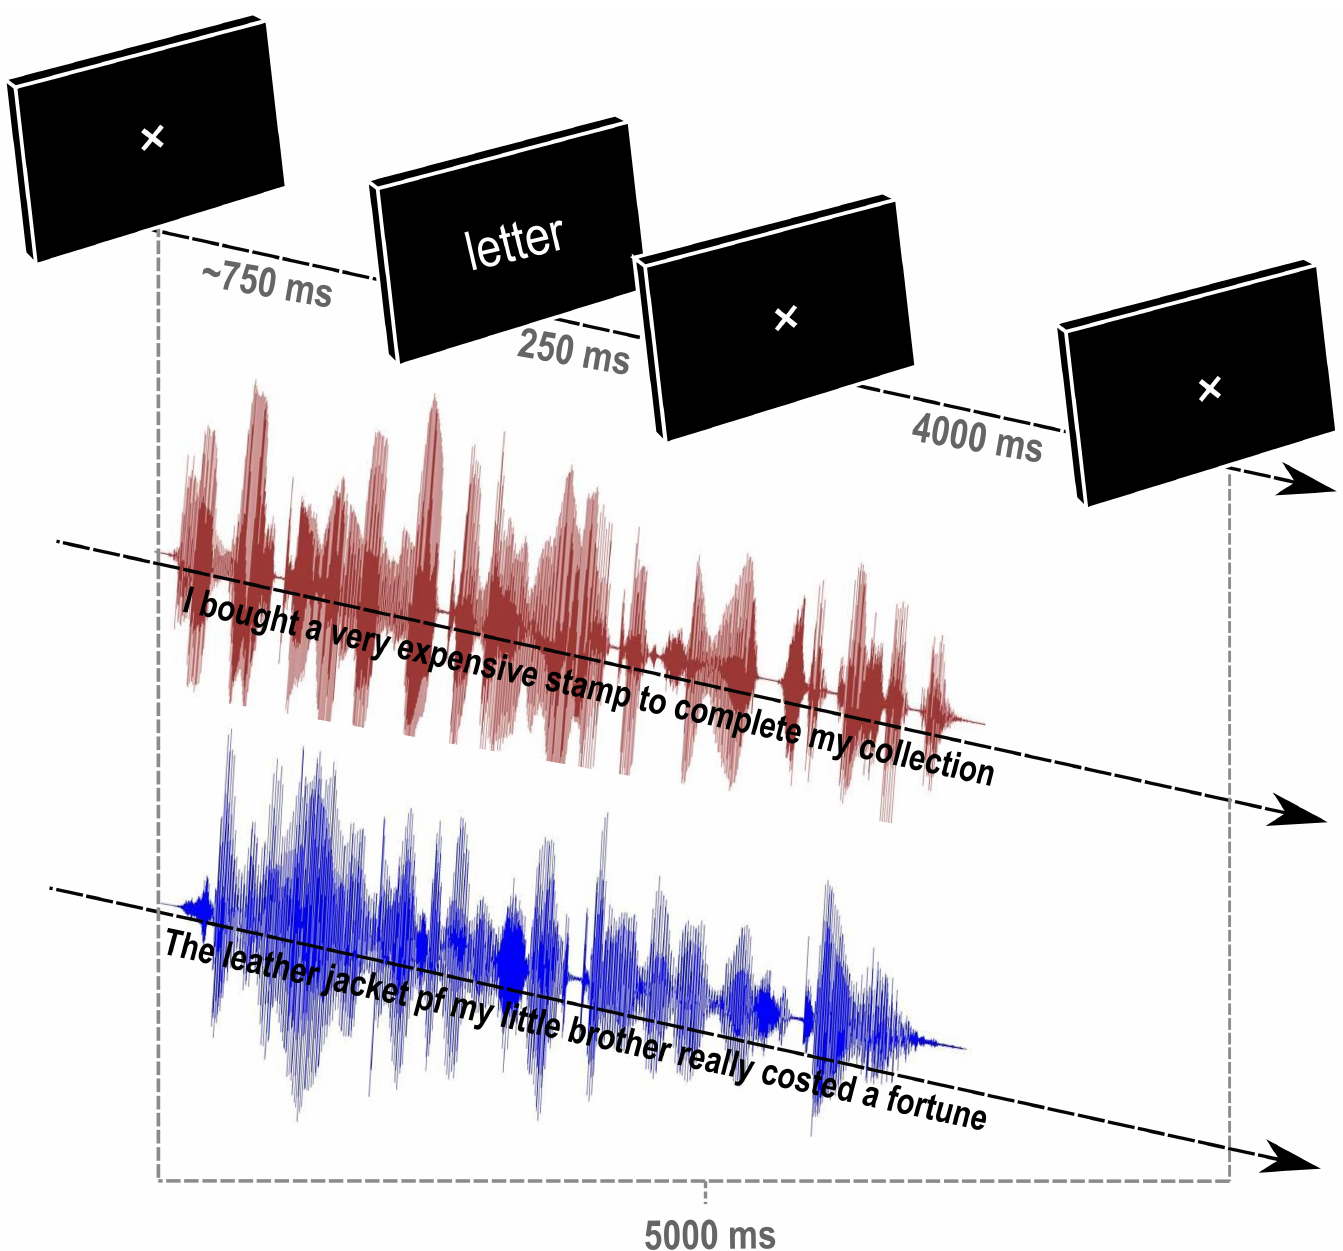
Fig 1. Cross-modal semantic priming paradigm in speech-in-speech situation. An exampleof one trial, with letter as the target written word and timbre “stamp” as the auditory prime. In this example,the prime was semanticallyrelated to the target (SEMR condition),and the relevant speech stream (A condition) was pronouncedby the female (represented by pink speech